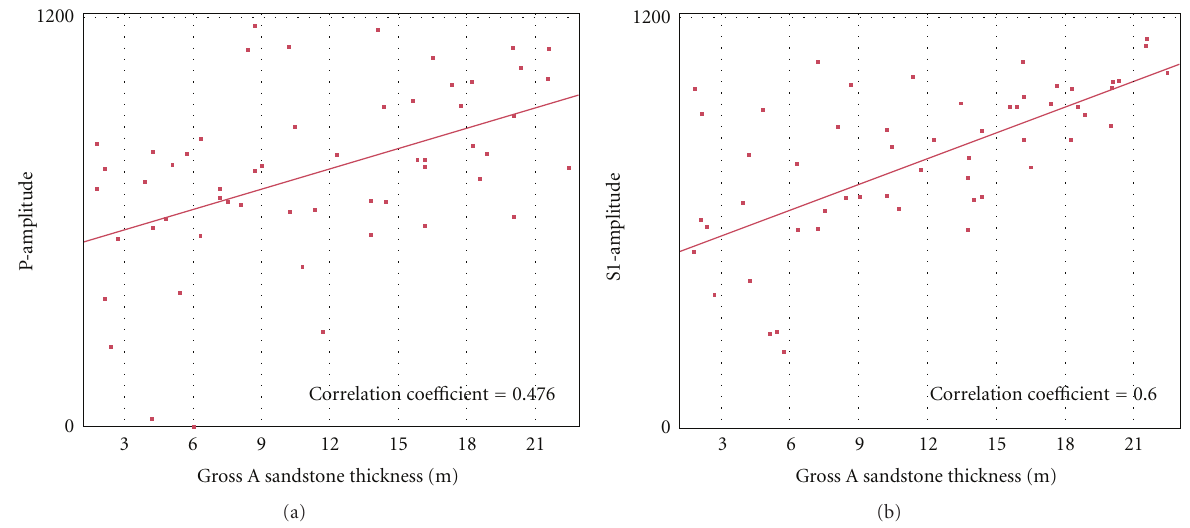
Figure 21: S1-wave amplitude map has a better correlation to gross A sandstone thickness than the P-wave amplitude map. For the S1-wave amplitude map, the correlation is not good when the sandstone thickness is less than 6.5m, whereas the P-wave amplitude map does not show good correlation even for thicker sandstones.